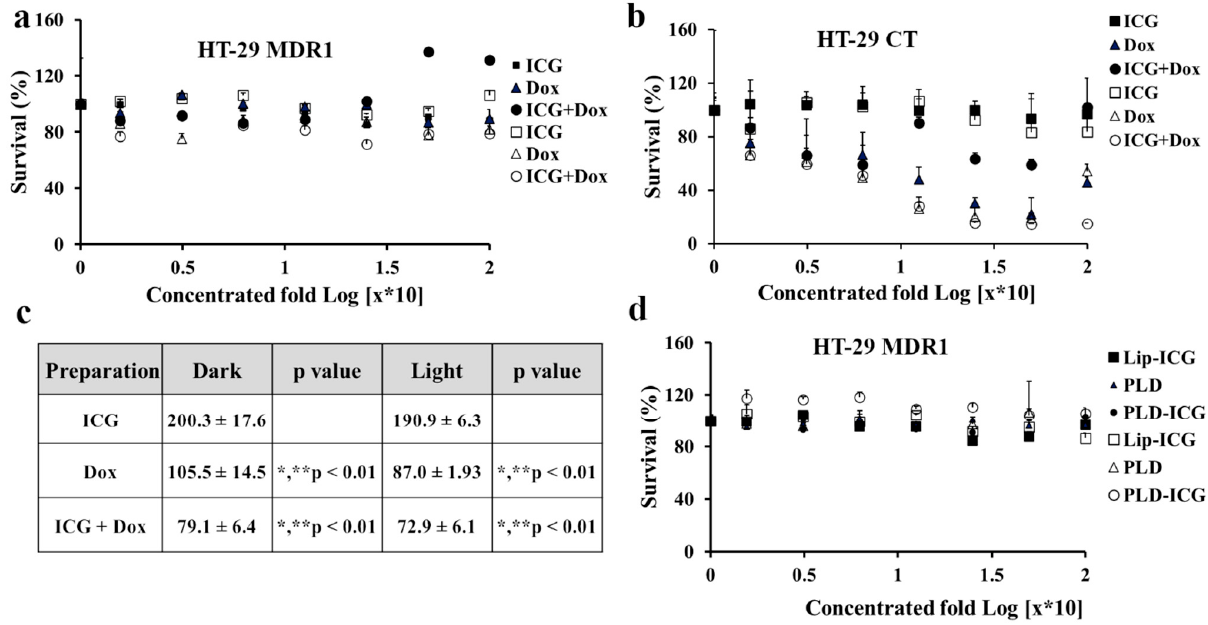
Figure 3. Toxicity of doxorubicin and ICG in HT-29 CT and HT-29 MDR1 cells with and without NIR irradiation. ( a ). Survival (%) HT-29 MDR1 cells treated by free ICG and doxorubicin. ( b ). Survival (%) HT-29 CT cells treated by free ICG or doxorubicin. ( c ). Analysis of area under the curve (AUC) of toxicity curves in HT-29 CT cells, based on Figure 2b. ( d ). Survival (%) HT-29 MDR1 cells treated by liposomal ICG and doxorubicin. % Survival normalized to control untreated cells. 2-way ANOVA Tukey Multiple Comparisons Test n = 6. The filled and open markers represent non-irradiated and irradiated cells, respectively. * compared to ICG, not irradiated, ** compared to ICG, irradiated. Values represent mean ± SD.